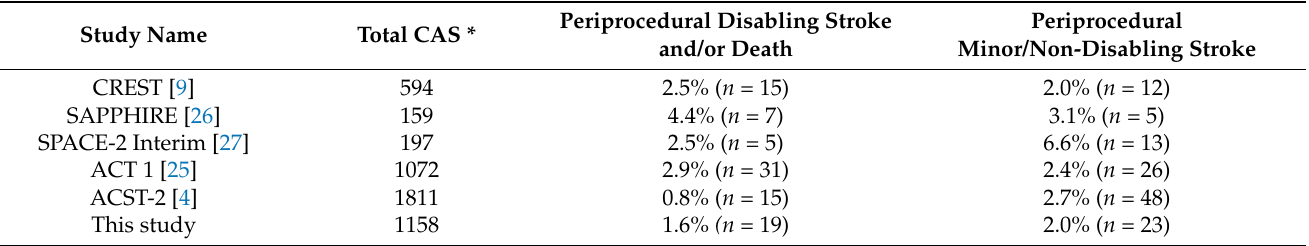
Table 7. Comparison of periprocedural complication rate in different randomized multicenter